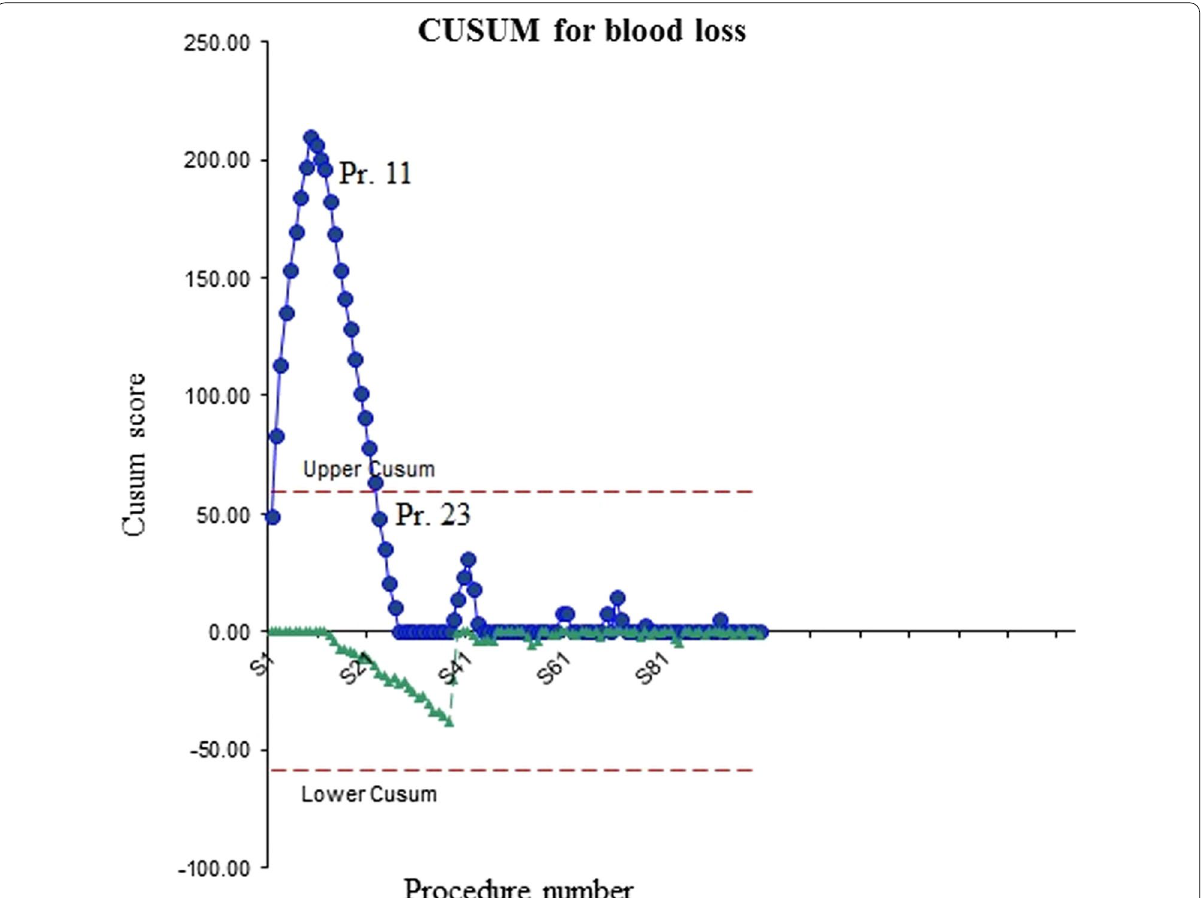
Fig. 4 CUSUM analysis of estimated blood loss (EBL); shows improvement of hemostasis by the 13th procedure, full control by the 29th procedure and proficiency at the 45th procedure